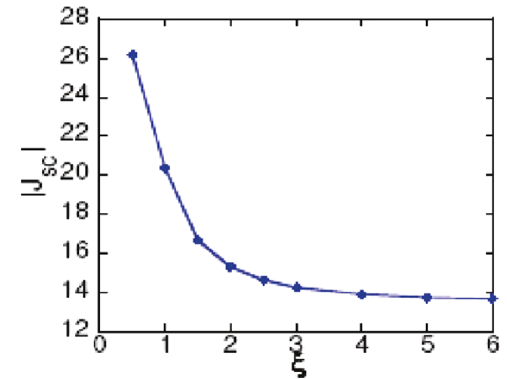
Figure 9. Calculated short-circuit current density J (mA/cm 2 ) in an OPV cell vs. the sc interface width ξ (nm) between the donor and acceptor domain. The assumed structure contains donor and acceptor domains perpendicular to the plane of electrode. Reprinted with permission from Reference [71]. Copyright 2010 American Chemical Society.